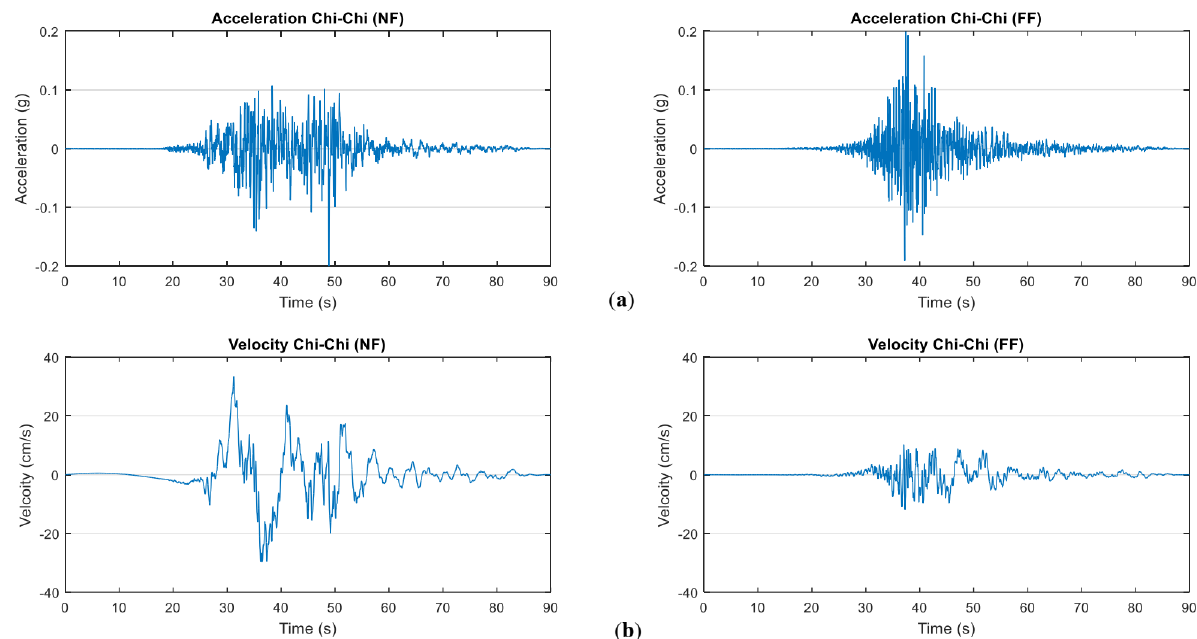
Figure 3. Near-fault and far-fault ground motions recorded at the Chi-Chi earthquake in 1999. ( a ) Acceleration time histories for near-fault and far-fault earthquake records. ( b ) Velocity time-histories for near-fault and far-fault earthquake records [72].